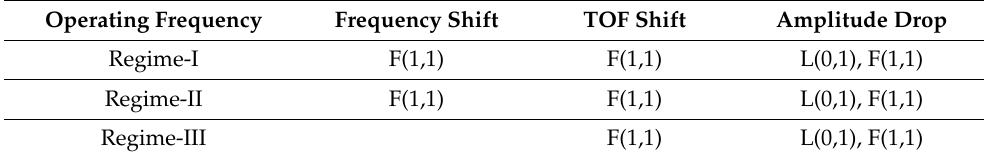
Table 2. Response of three-wave mode to inviscid fluid loading at different operating frequency